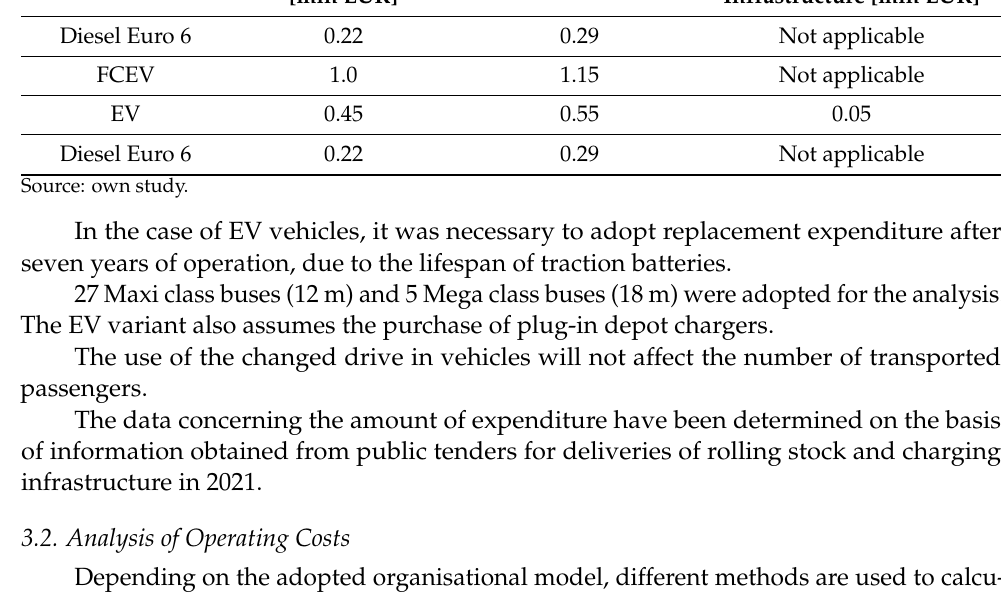
Table 4. Assumptions concerning unit investment expenditure.